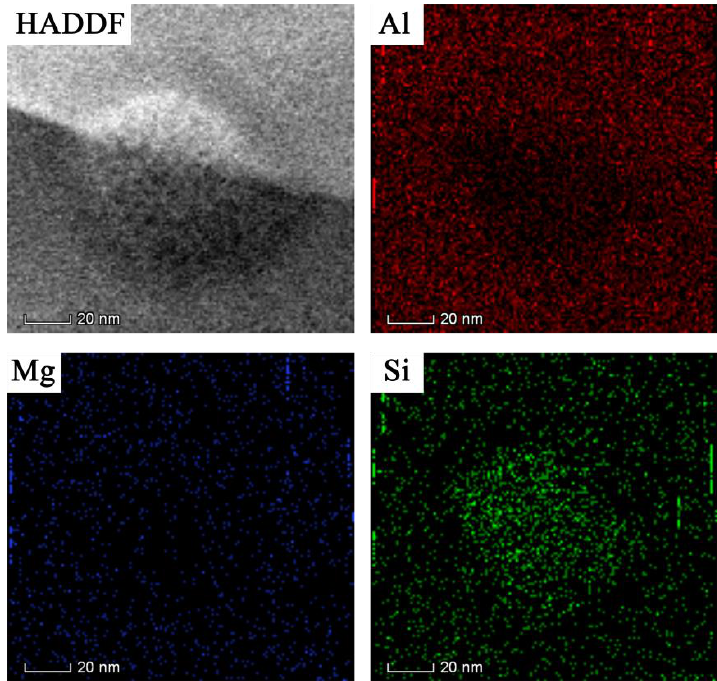
Figure 7. Transmission electron microscopy (TEM) images of grain-boundary precipitates in the three investigated specimens: ( a ) A1, ( b ) A3 and ( c ) A6.